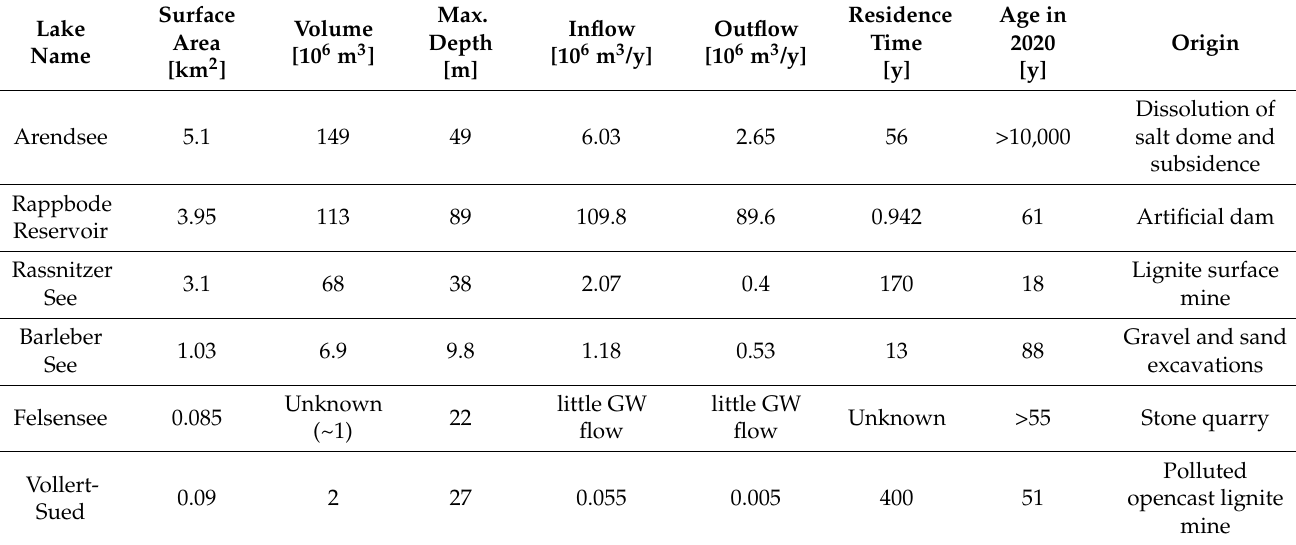
Table 2. Properties of the investigated lakes (residence time was calculated as volume by outflow); the origin of the data is supplied in the text of Section 3.1 for each lake in